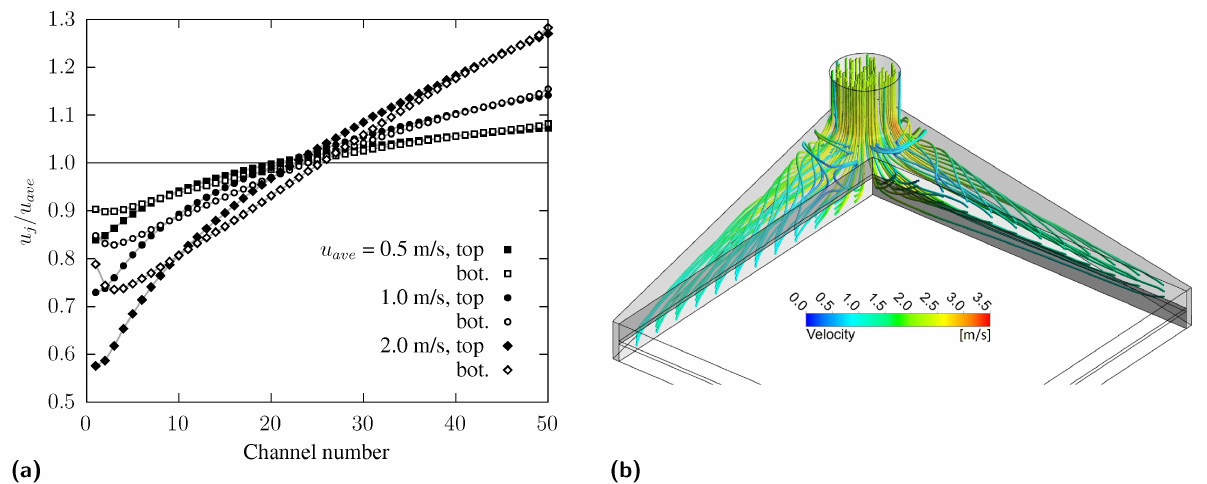
Figure 5. Header without baffle: ( a ) normalized velocity distributions obtained with different average velocities u ave for top and bottom layers; ( b ) pathlines in the inlet header for u ave = 1.0 m/s, colored by velocity